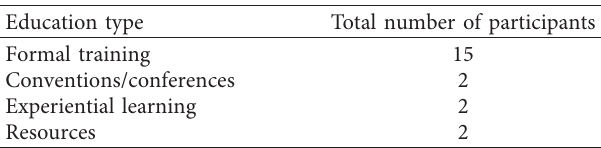
Table 3: Modes of educating police on strategies for lost persons with